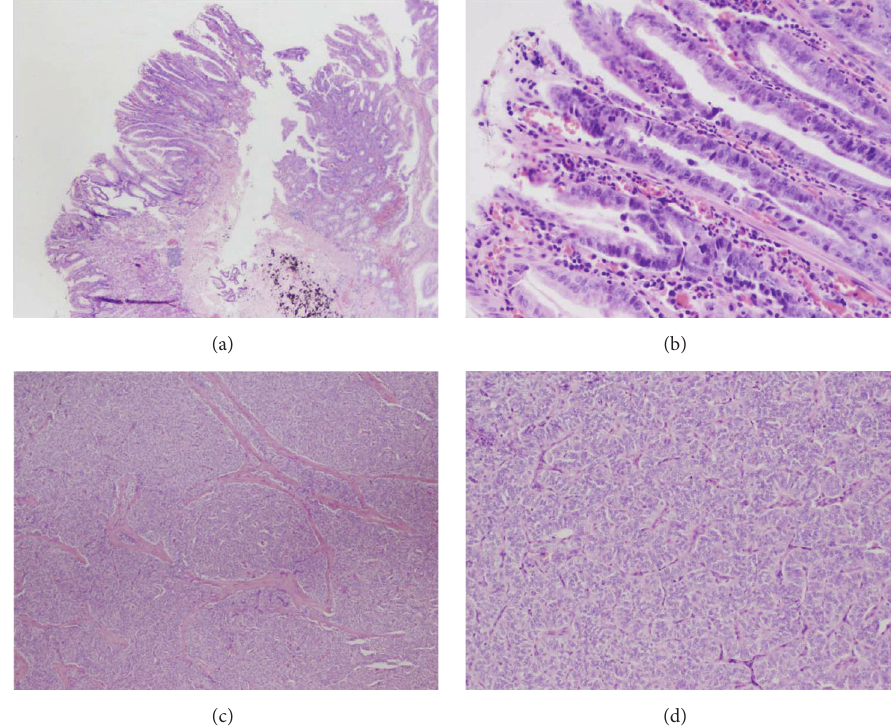
Figure 2: (a) Tubular adenoma adjacent to the black tattoo ink (H&E, 20x). (b) Higher power view of the adenoma with GED (H&E, 200x). (c) Metastasis to the perigastric lymph nodes: the neuroendocrine component is composed of relatively monomorphic cells with amphophilic cytoplasm and round nuclei in trabecular to nested arrangements (H&E, 40x). (d) Higher power view of neuroendocrine elements (H&E, 100x).